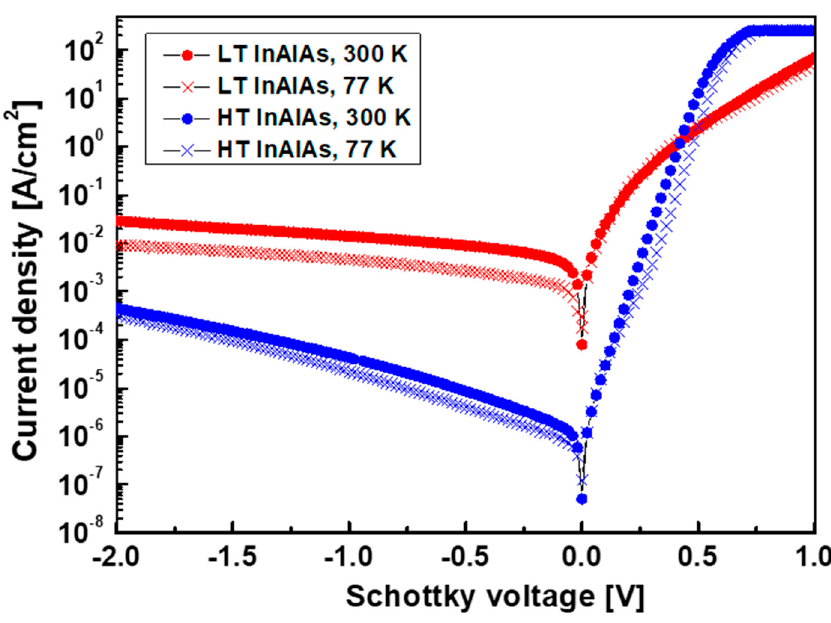
Figure 6. Semi-logarithmic current density–voltage graphs of HT- and LT-InAlAs Schottky diodes measured at 77 K and 300 K. Schottky contact area is 4 × 10 − 4 cm − 2 .